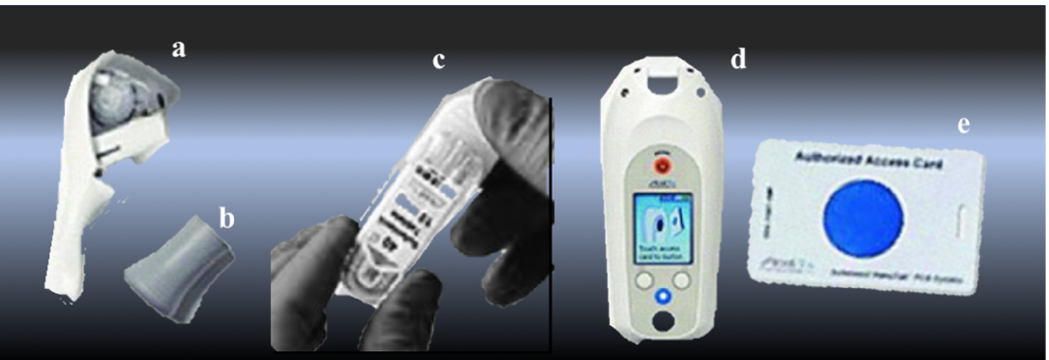
Figure 1. The Zalviso ® system consists of a disposable dispenser tip ( a ) and dispenser cap ( b ); a cartridge of Sufentanil sublingual 15 mcg tablets in a disposable bar-coded cartridge ( c ); a reusable handheld controller ( d ) and an authorized access card ( e ).